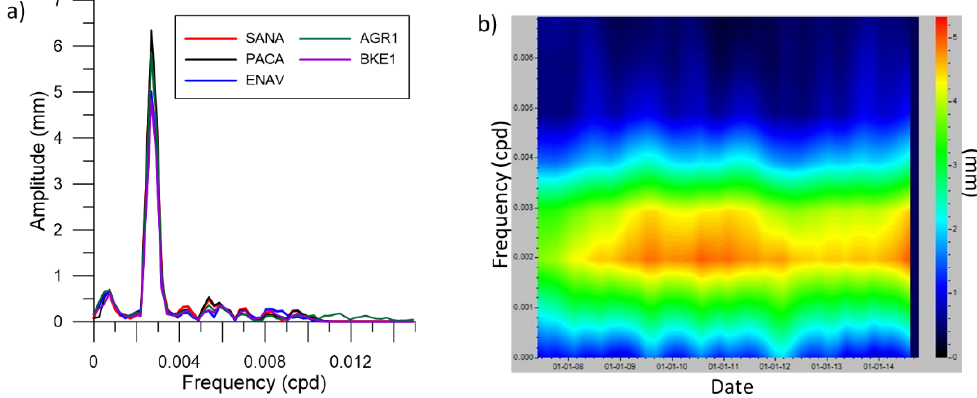
Figure 3. Spectral analysis of the low-pass-filtered daily PWV (like the red curve in Figure 2a) at five stations of the network; FFT amplitude spectrum ( a ) and a spectrogram of PWV time series at AGR1 ( b ); units of frequency are cycles per day (cpd).